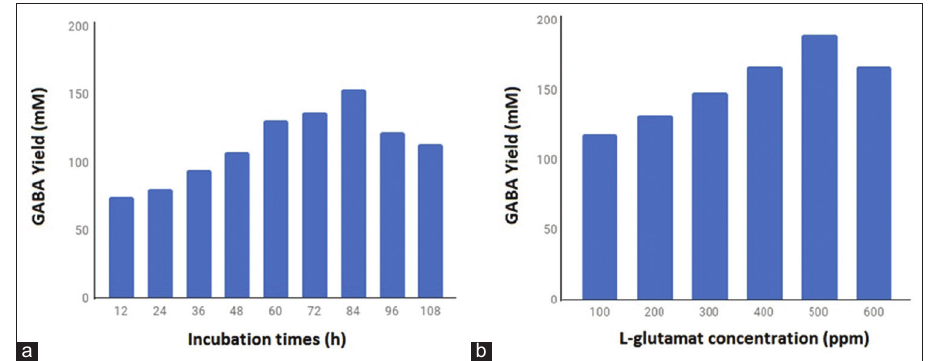
a b Figure-3: Effect of incubation time (a) and L-glutamate concentration (b) on γ-aminobutyric acid production by Lactobacillus plantarum N5.